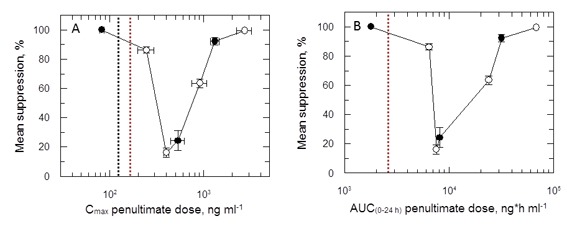
(A and B) Mean suppression of parasite burden as a function of Cmax for the penultimate dose and extrapolated AUC(0–24 hr) for the last day of the 5- and 10-day treatment regimens, respectively.Open and closed symbols represent data combined from the 5- and 10-day studies, respectively. This graph represents the aggregated data from 3 separate in vivo studies. The black dotted line in (A) is the EC90 value obtained for infected macrophages after 72-hr exposure. The red dotted line in (A) and (B) represents the mean delamanid Cmax (375–400 ng ml-1) and mean AUC(0–24 hr) (7000–8000 h*ng ml-1) obtained in TB patients after 14 days treatment with 100 mg, oral, once daily (Sasahara et al., 2015).